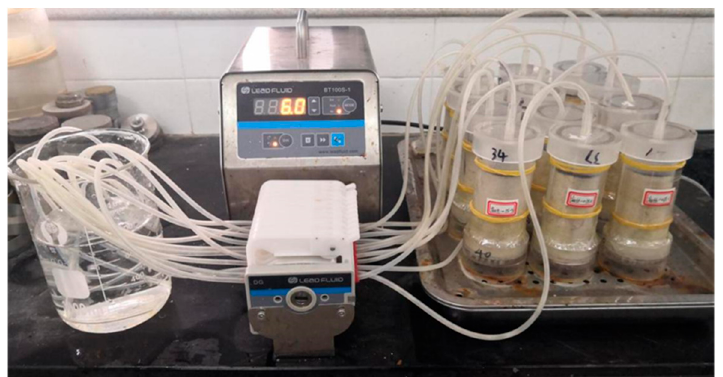
Figure 5. Grouting procedure of the peristaltic pump.